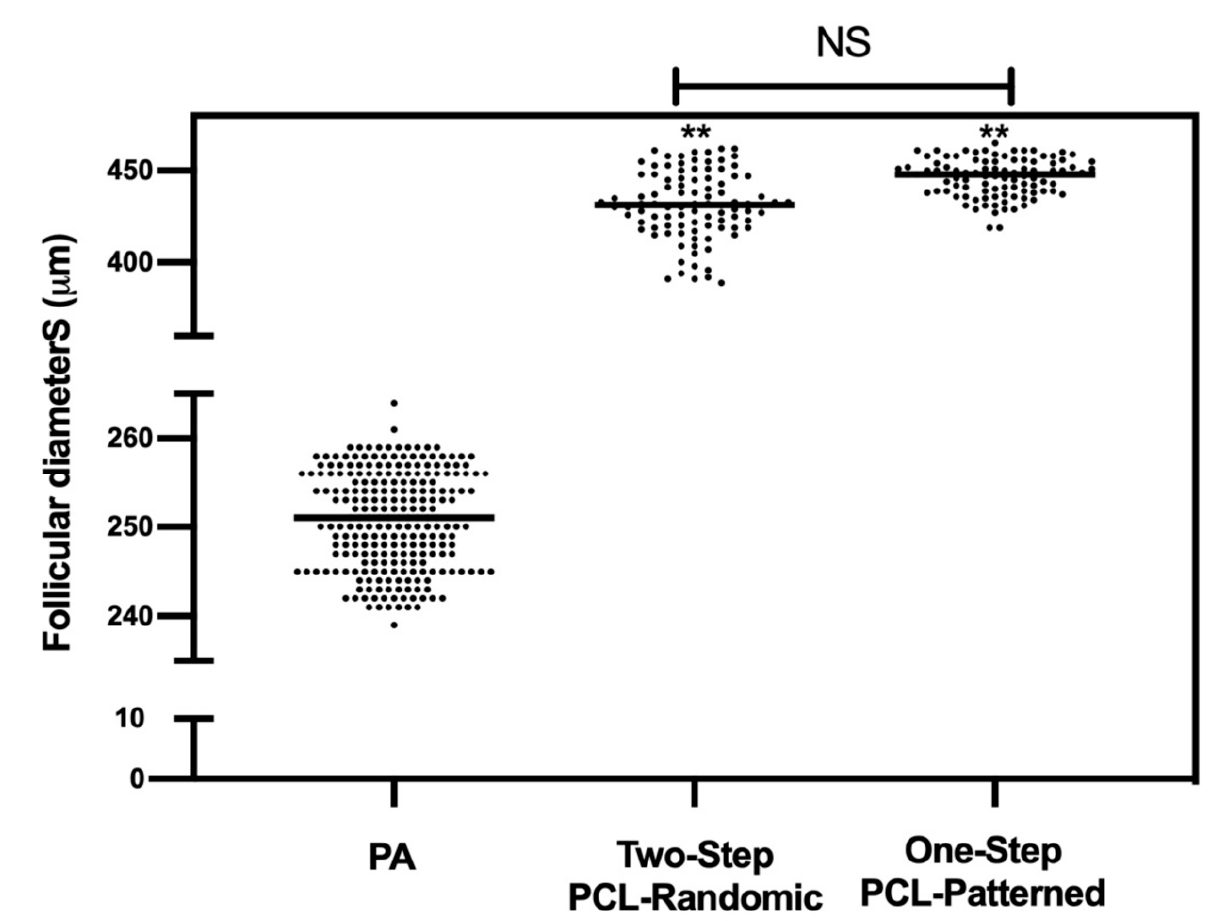
Figure 10. EA follicular mean final diameters: overview for each experimental group. A total of 120 and 120 follicles were cultured in three independent experiments during which Two-Step PCL-Patterned and One-step PCL-Patterned electrospun scaffolds were simultaneal compared (Two-Step PCL-Patterned: 40, 40, and 40 PA follicles per experiment; One-Step PCL-Patterned: 40, 40, and 40 PA follicles per experiment). **: statistically significant vs. PA follicles group ( p < 0.01). NS: not statistically significant.